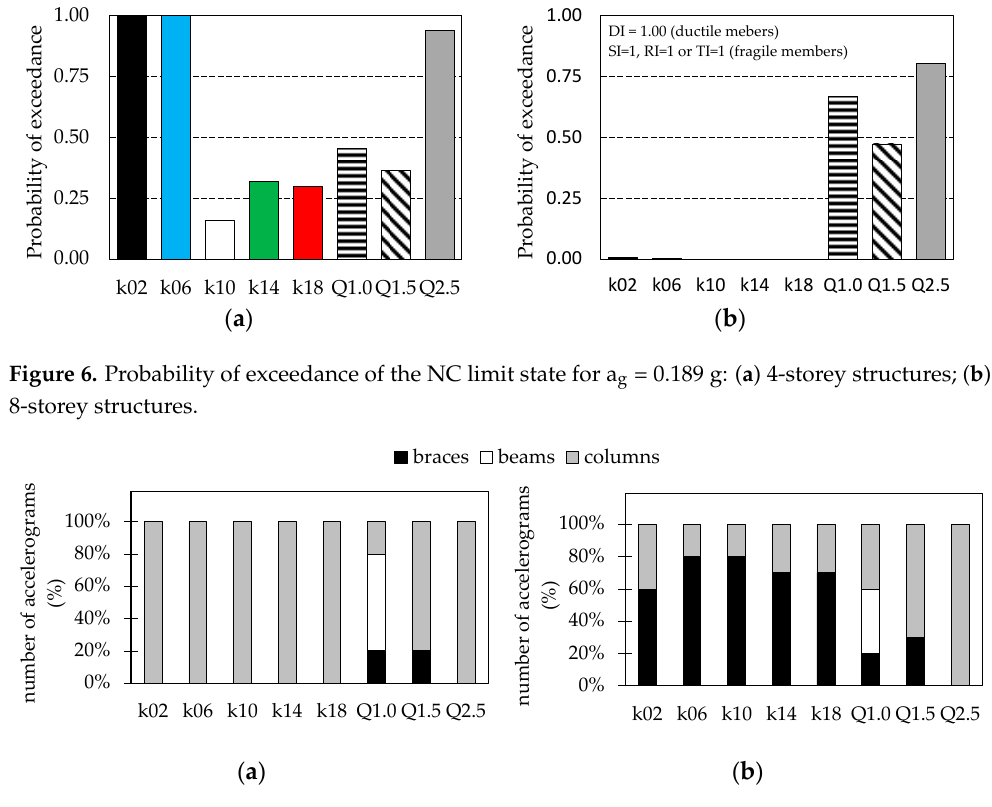
Figure 7. Percentage number of accelerograms leading to DI = 1.00 in braces or RI = 1, SI = 1, TI = 1 in beams and columns: ( a ) 4-storey structures; ( b ) 8-storey structures.